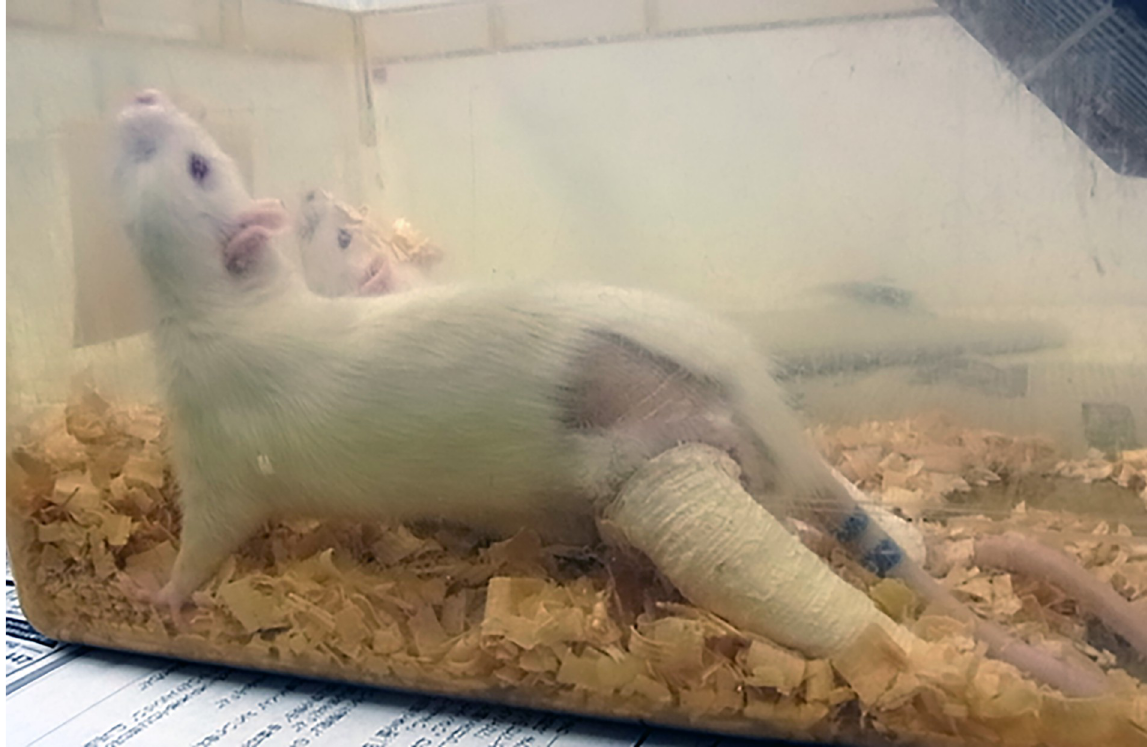
Fig 1. Immobilized animal model. Bilateral hind limbs of 8-week-old male SPF Wistar rats are fixed with the knee in a fully extended position using plaster casts.